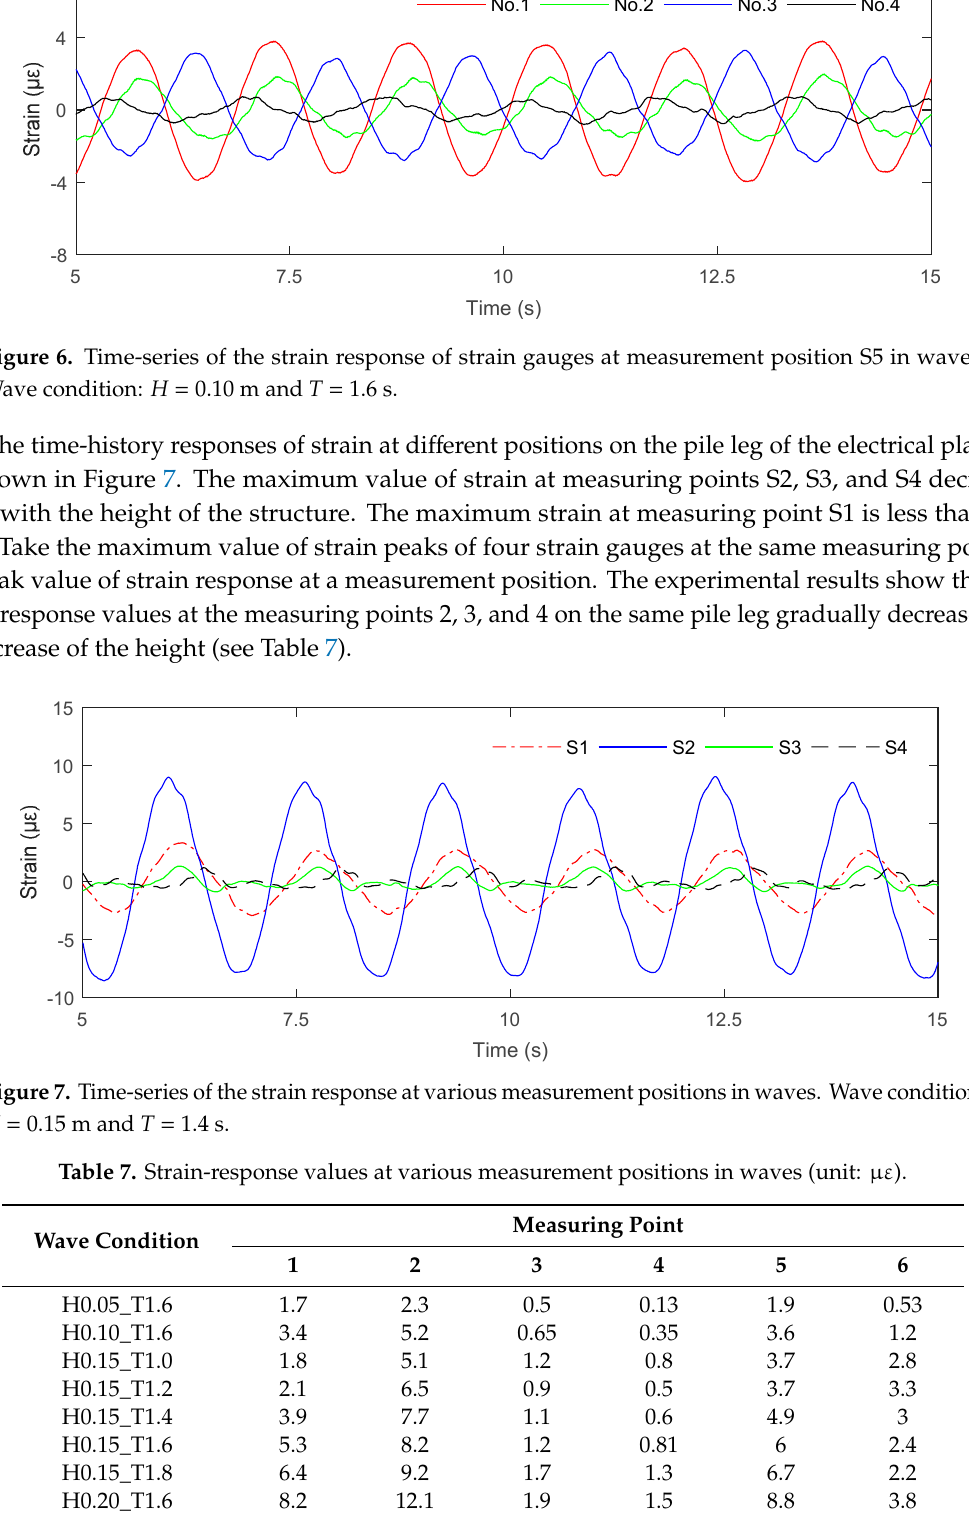
Figure 7. Time-series of the strain response at various measurement positions in waves. Wave condition: H = 0.15 m and T = 1.4 s. Table 7. Strain-response values at various measurement positions in waves (unit: µε ). Wave